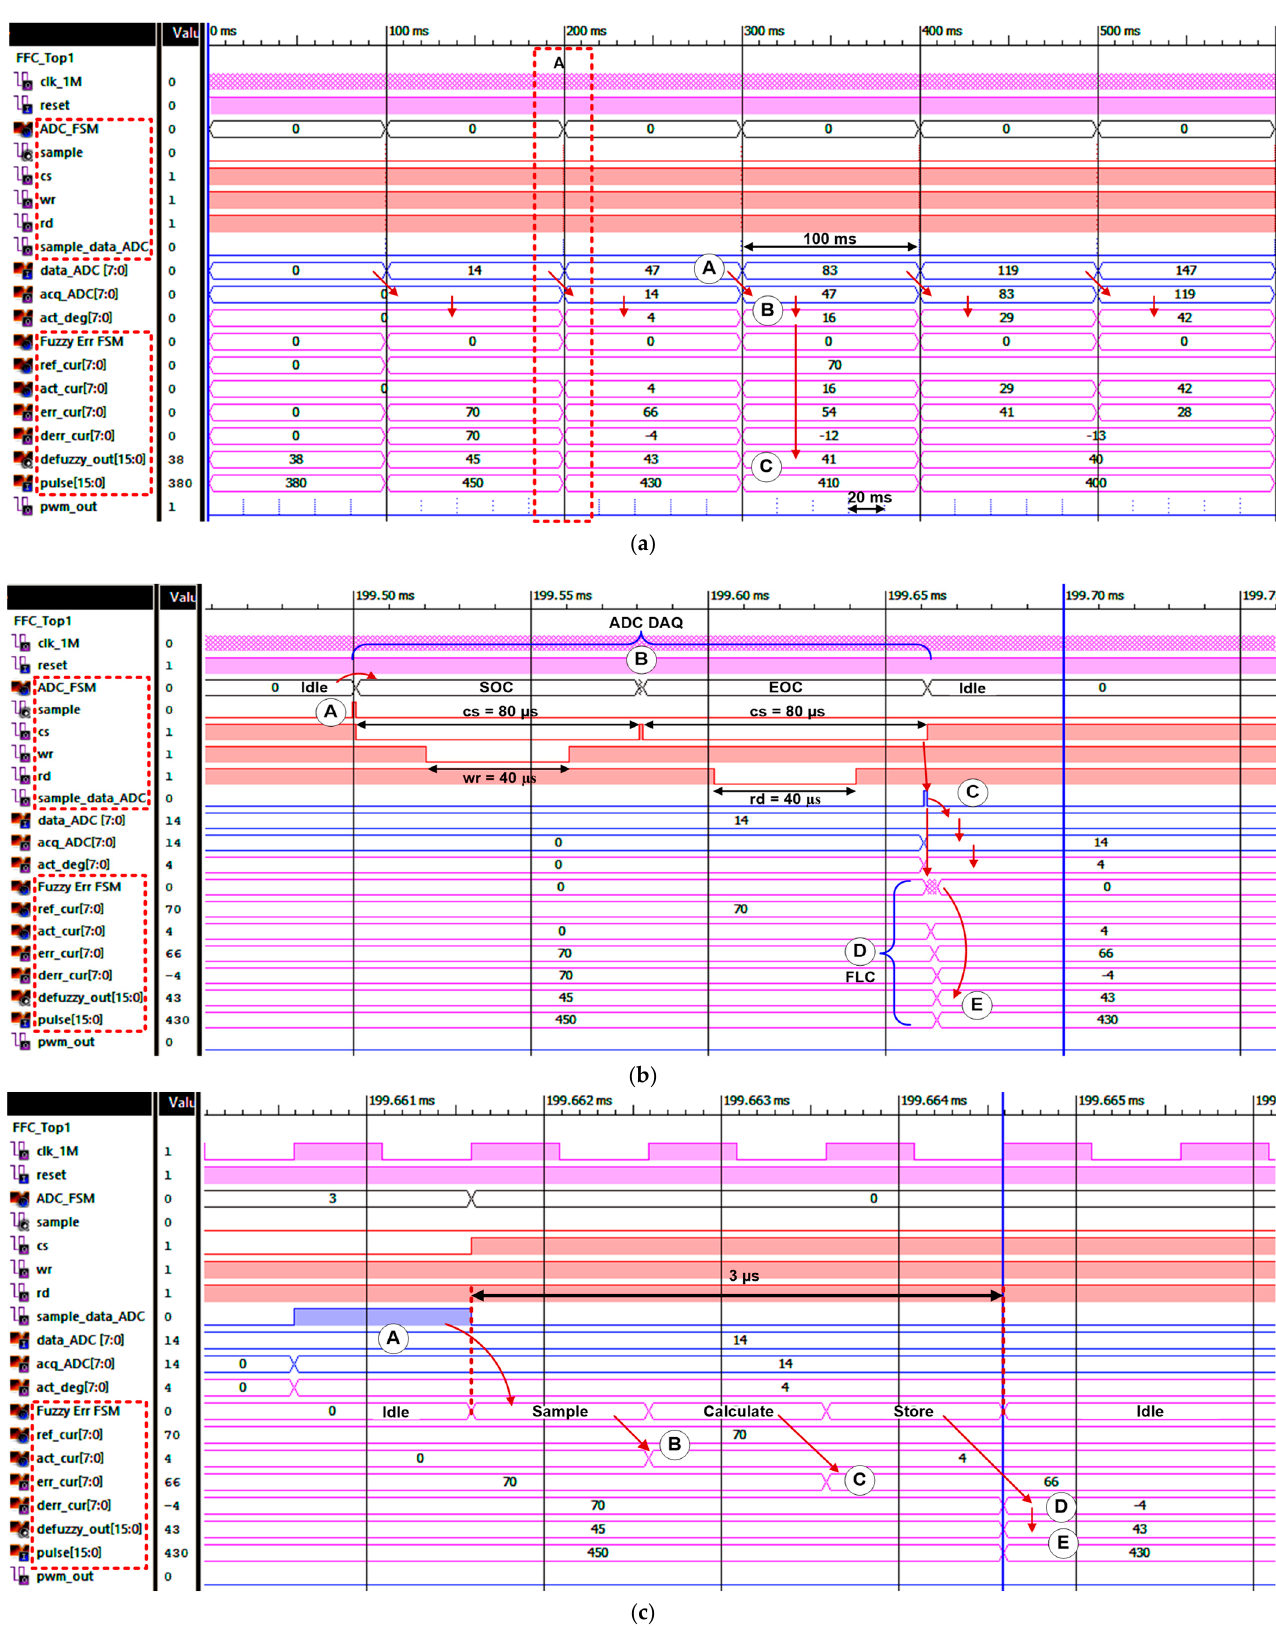
Figure 15. Register transfer level (RTL) simulation results of the digital FFC: ( a ) Overall FFC operation; ( b ) Zoom view into marked area A; ( c ) Zoom view into the FLC sub-module’s timing diagram.